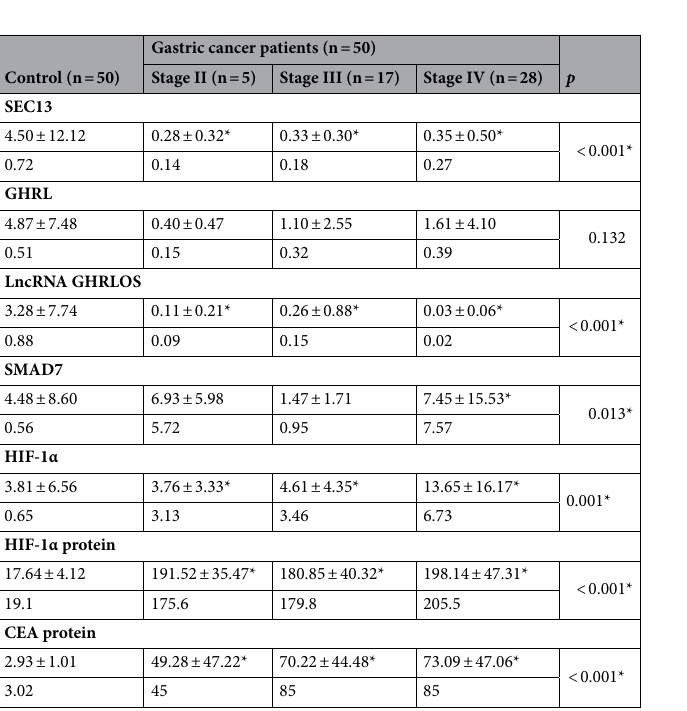
Table 4. SEC13, GHRL, lncRNA GHRLOS, SMAD7, HIF-1α genes expression, serum HIF-1α and CEA levels in control and gastric cancer patients’ groups with different stages. P: P value for comparing between all groups utilizing Kruskal Wallis test, pairwise comparison between each two groups was performed by Post Hoc Test. *Significance at P ≤ 0.05.